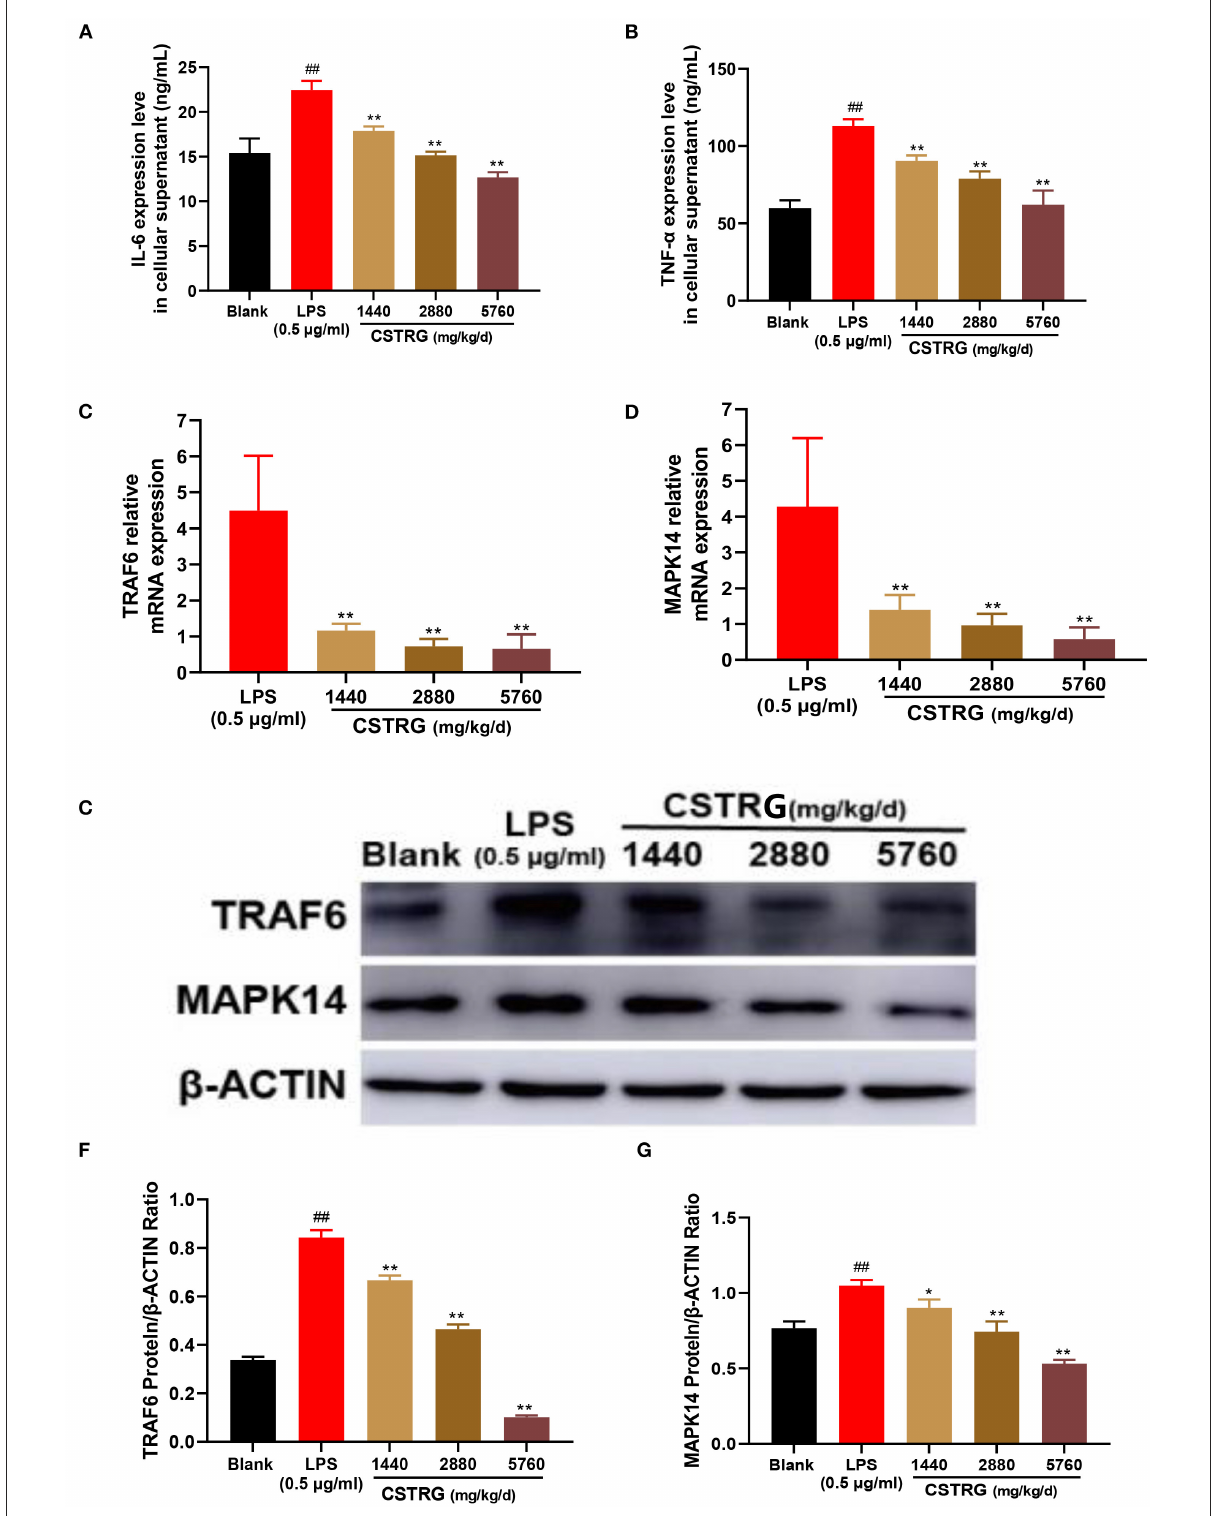
FIGURE6 CSTRG exhibits anti-inflammatory activity effects in LPS-stimulated RAW264.7 cells by attenuating the TRAF6/MAPK14 axis. (A,B) The levels of TNF- α and IL-6 in the culture supernatants were detected by ELISA kits. (C,D) The mRNA levels of TRAF6 and MAPK14 were determined by qPCR analysis. (E–G) The protein levels of TRAF6 and MAPK14 were determined by western blot analysis. The data are presented as the means ± standard deviations of the results from three independent experiments. Compared with blank group: # p < 0.05; ## p < 0.01; compared with model group; * p < 0.05; ** p <